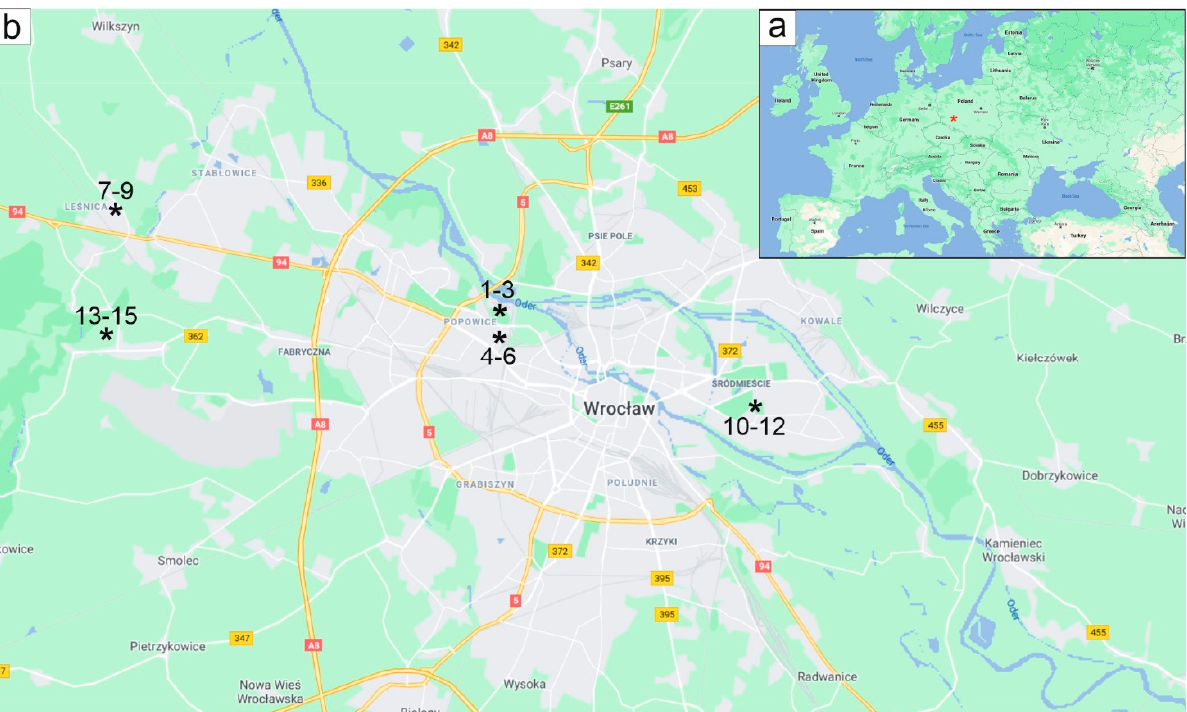
Table 1. Location of the analysed trees of A. hippocastanum sampled in 2014 and 2015.